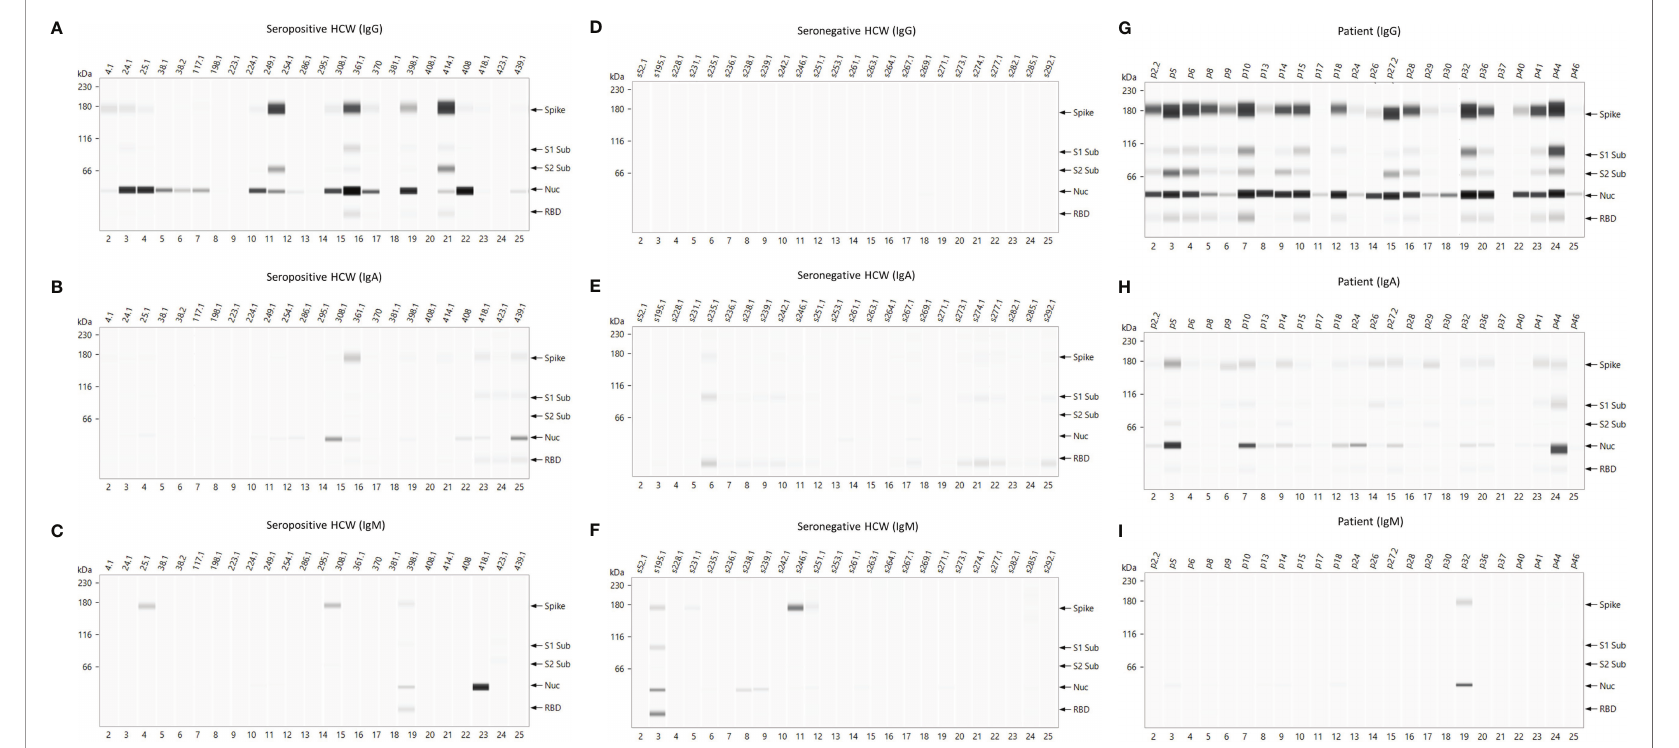
FIGURE 5 | Representative electropherograms of IgG, IgA and IgM antibody responses to Spike, RBD, S1, S2 and N antigens of SARS-CoV-2 in Health Care Workers and Patients. The fi gure shows antigen- speci fi c IgG (A, D, G) , IgA (B, E, H) and IgM (C, F, I) antibody reactivities of seropositive HCWs (left panel), serongative HCWs (middle panel), and patients (right